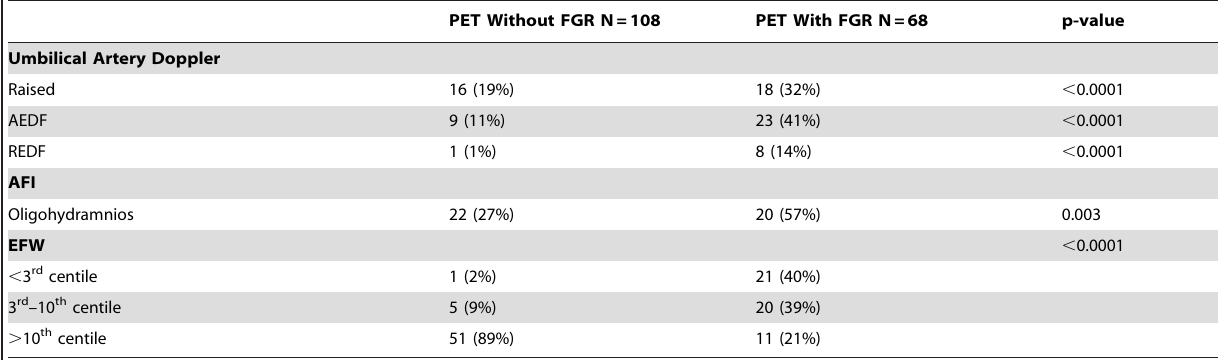
PET Without FGR N=108